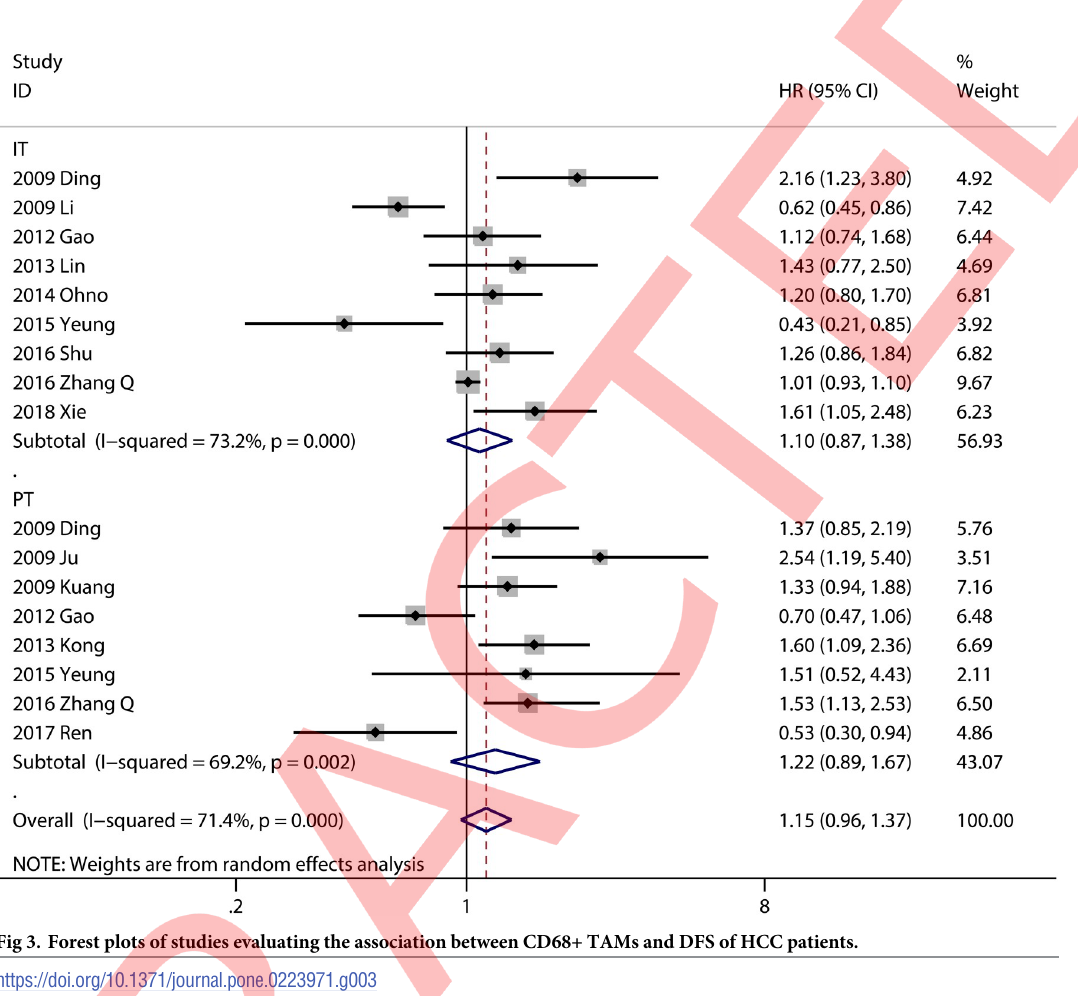
Fig 3. Forest plots of studies evaluating the association between CD68+ TAMs and DFS of HCC patients.